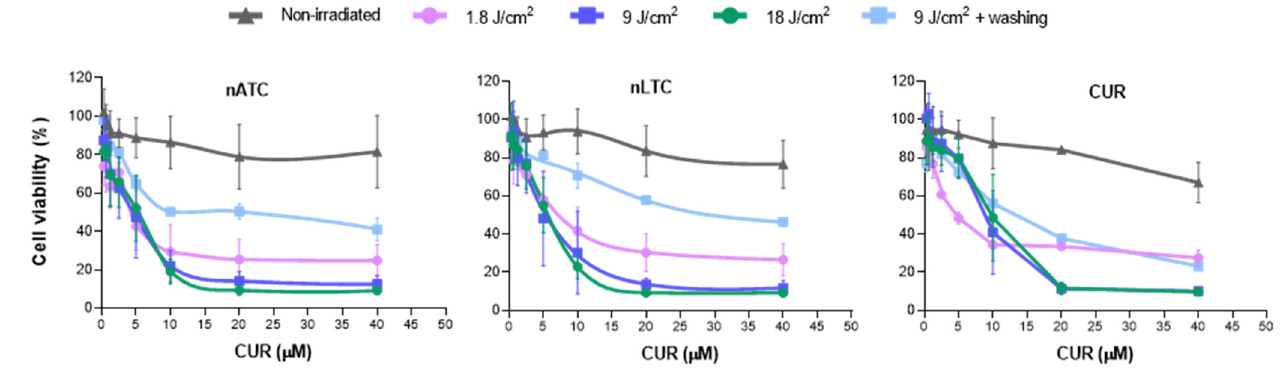
Figure 3. PDT on A549 cell line. Cells were incubated with nATC, nLTC, or free CUR and irradiated with a fluence of 1.8, 9, and 18 J/cm 2 or kept in the dark (non-irradiated). In addition, cells were incubated with formulations, washed with PBS, and irradiated with a fluence of 9 J/cm 2 . Cell viability was determined after 24 h incubation by MTT. Table 1. IC 50 values ( μ M) on A549 cell line with 1.8, 9 and 18 J/cm 2 fluences 1 . Formulation